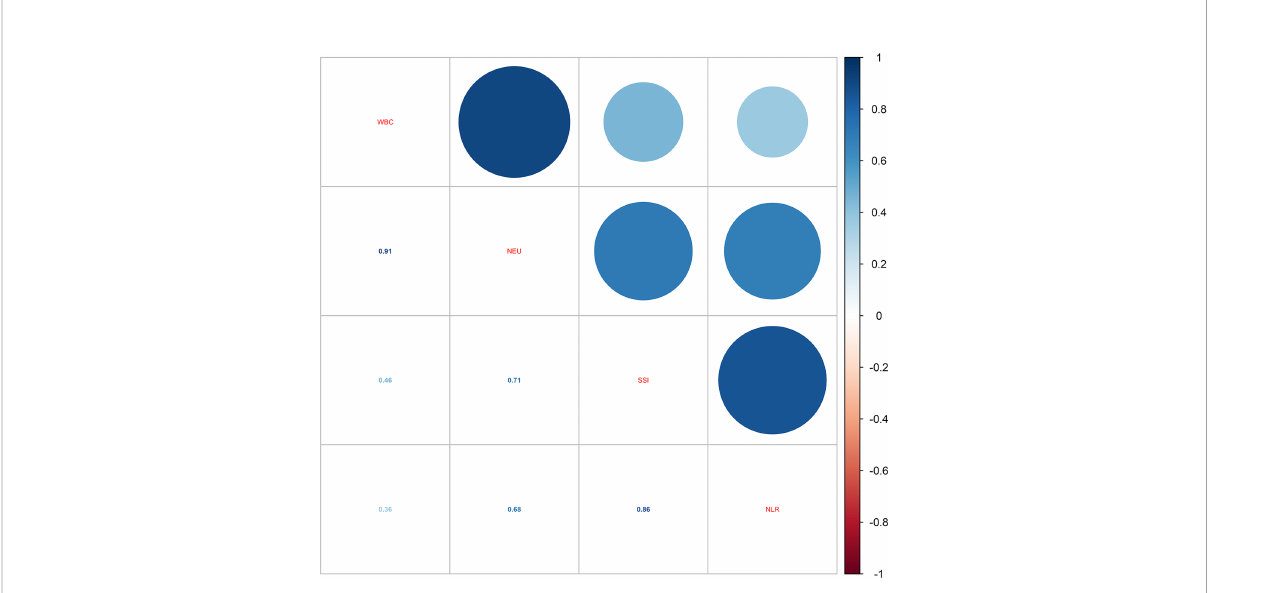
FIGURE 2 Correlations of the four blood in fl ammatory